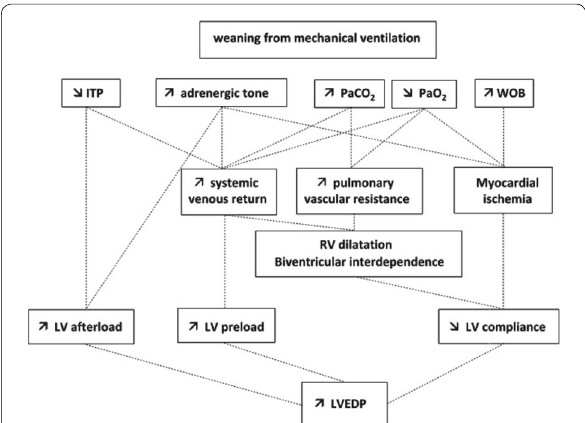
Fig. 1 Main mechanisms potentially involved in the development of weaning-induced pulmonary edema. ITP intrathoracic pressure, LV left ventricular, LVEDP left ventricular end-diastolic pressure, PaO 2 oxygen arterial pressure, PaCO 2 carbon dioxide arterial pressure, RV right ventricular, WOB work of breathing (adapted from